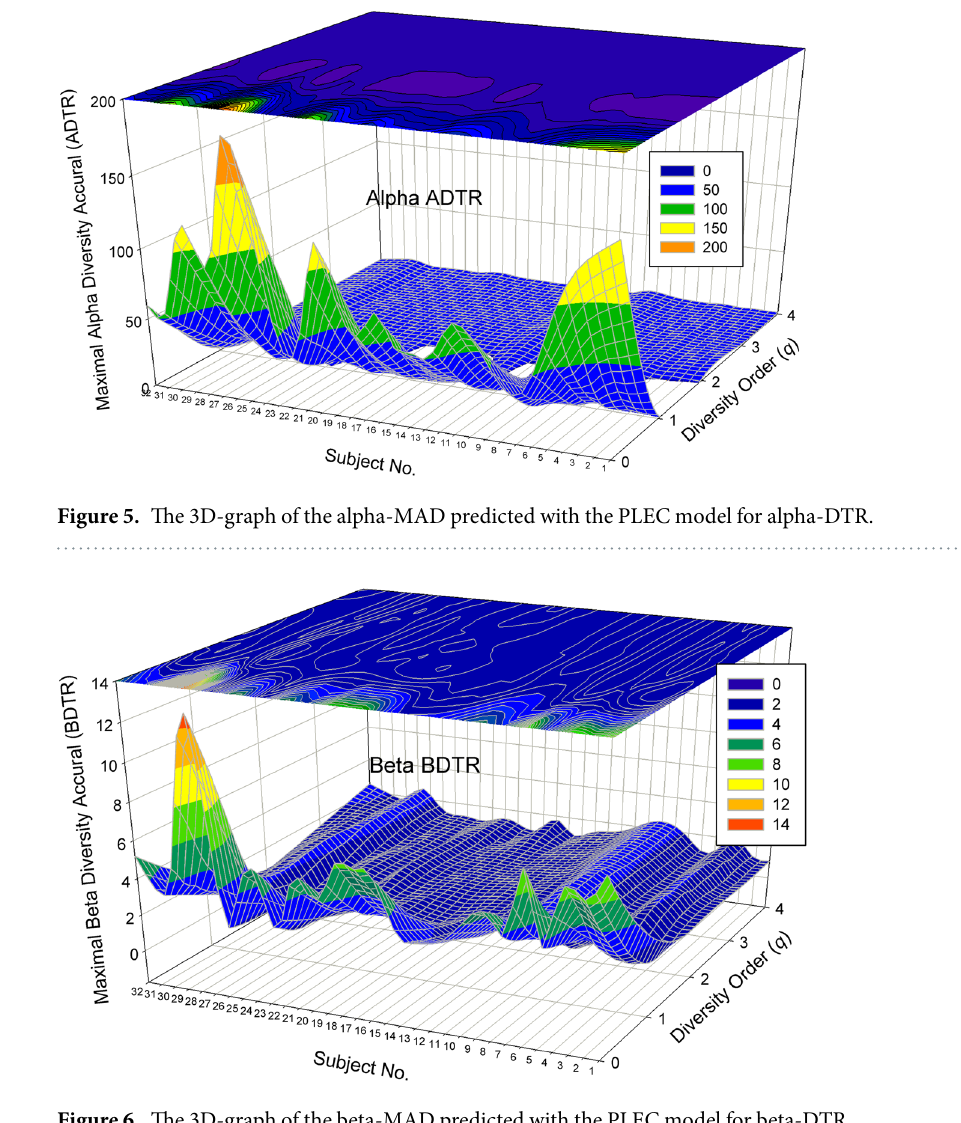
Figure 6. The 3D-graph of the beta-MAD predicted with the PLEC model for